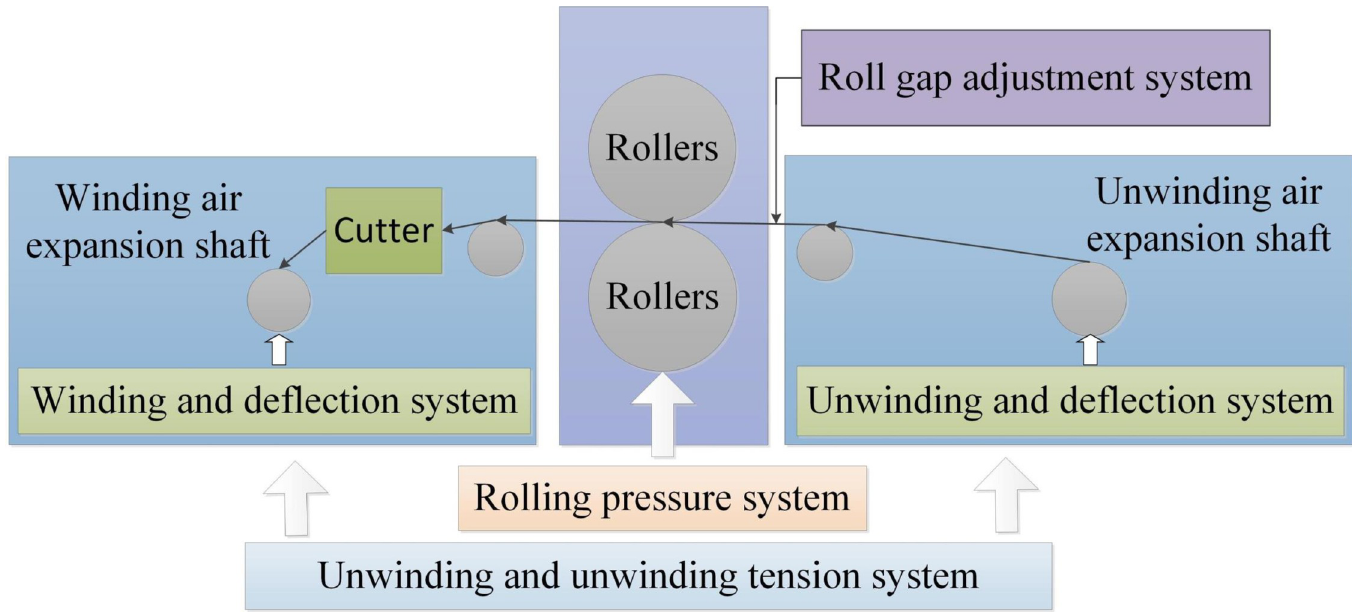
Fig 2. Schematic diagram of lithium battery pole plate rolling mill